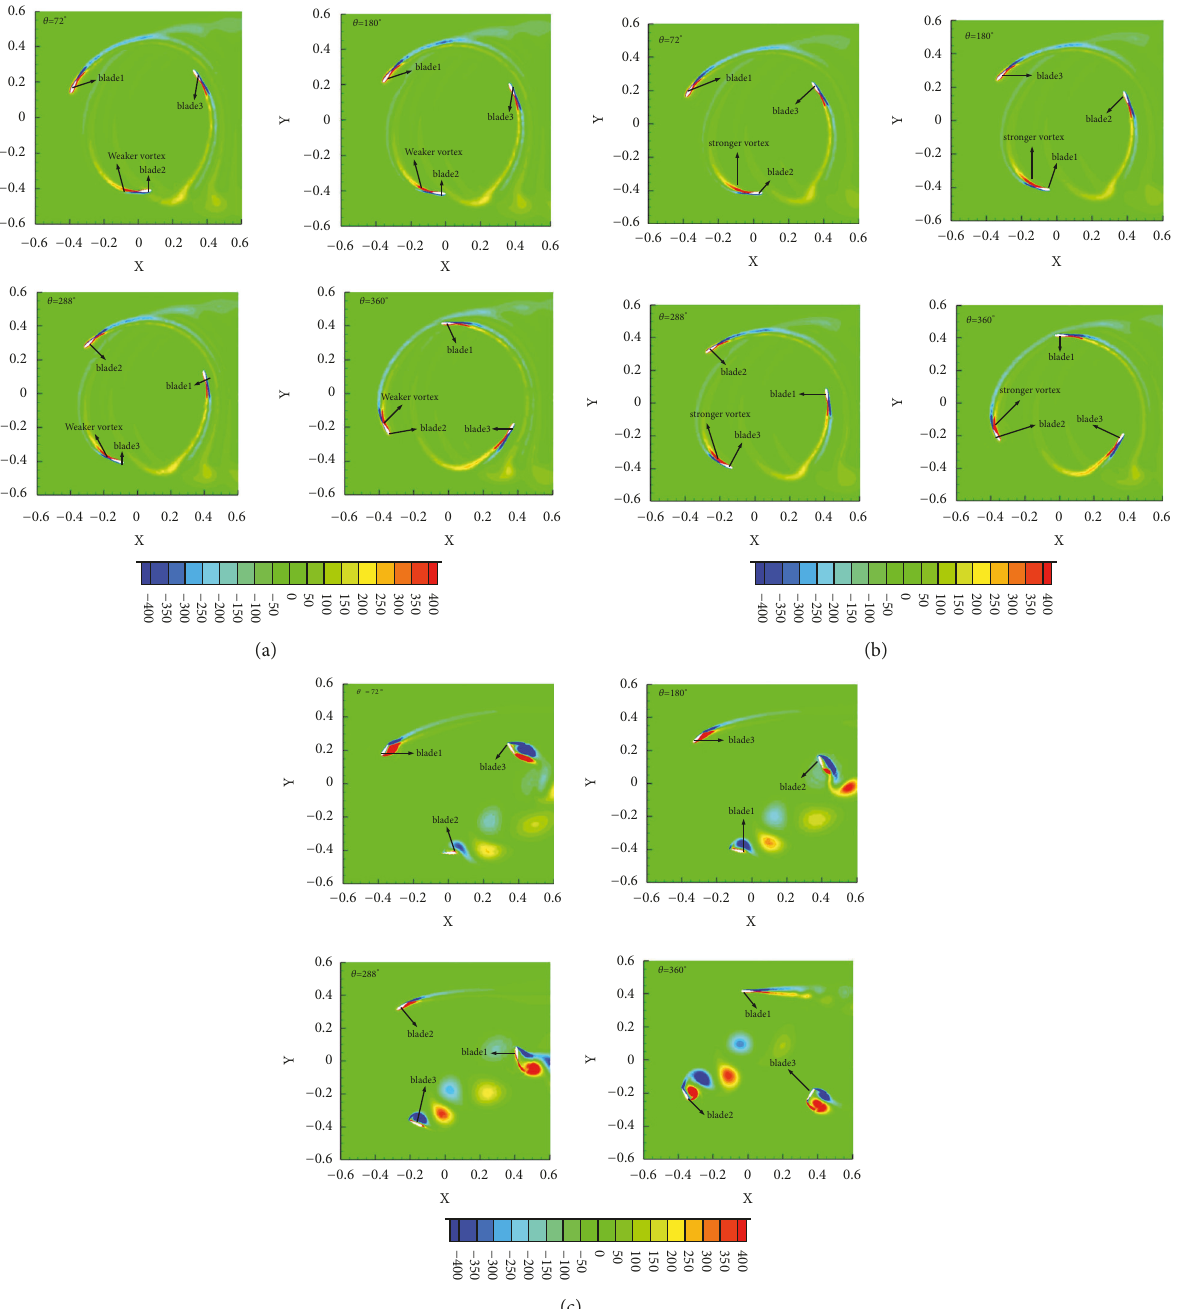
5 the blade at Re = 6.82 × 10 , while the angle of attack of the H-VAWT with 𝜓 =1.00 is larger than the stall angle of the blade, which results in the H-VAWT with 𝜓 =0.80 having larger power coefficient and the H-VAWT with 𝜓 =1.00 having smaller power